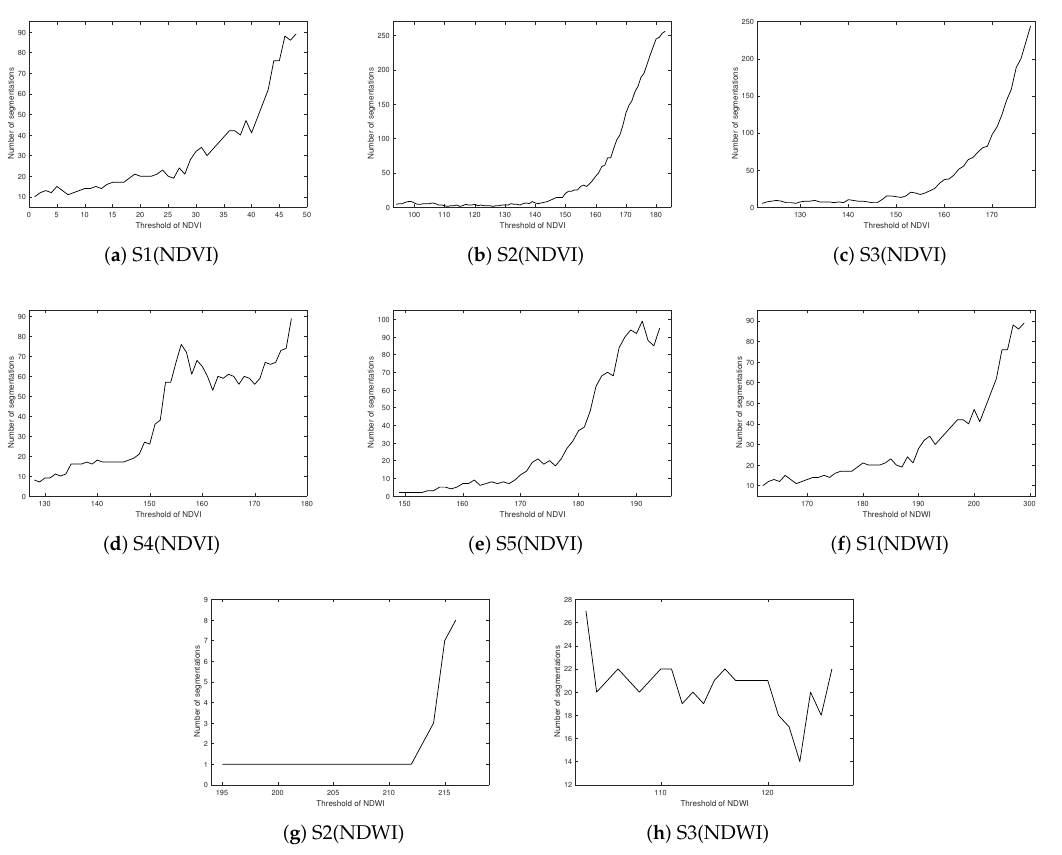
Figure 10. The number of segmentations when the threshold was selected from the range of [ T ] on subset image. trough , T peak